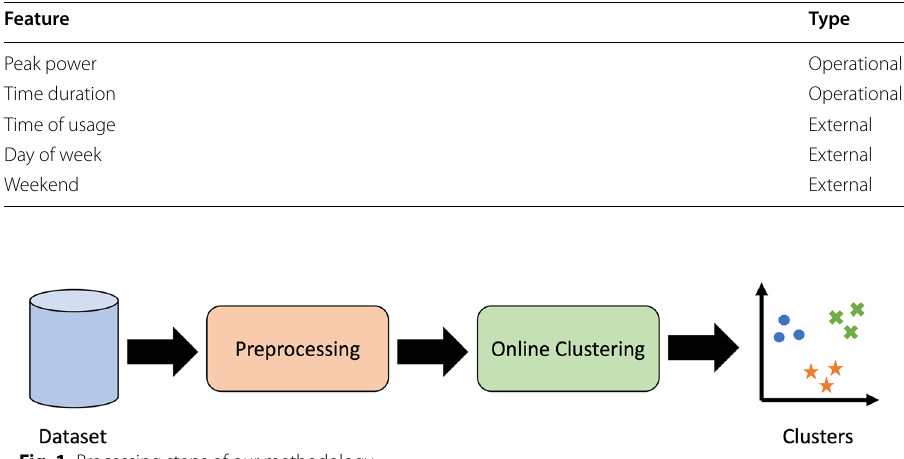
Table 1 Set of features characterizing a single unknown